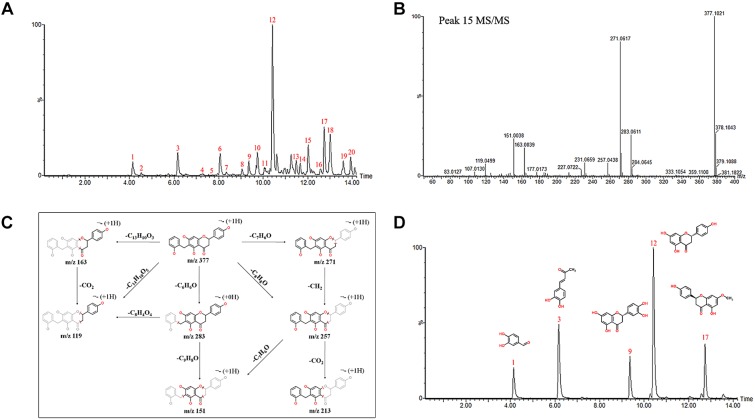
(A) UPLC-ESI-Q/TOF-MS BPI chromatogram of DCMPI. (B) Mass fragment spectrum of Phelligrin A in the negative ion mode. (C) Possible fragmentation mechanistic pathway of Phelligrin A. (D) Typical mixed standard substance chromatograms of protocatechuic aldehyde, osmundacetone, eriodictyol, naringenin, and sakuranetin.